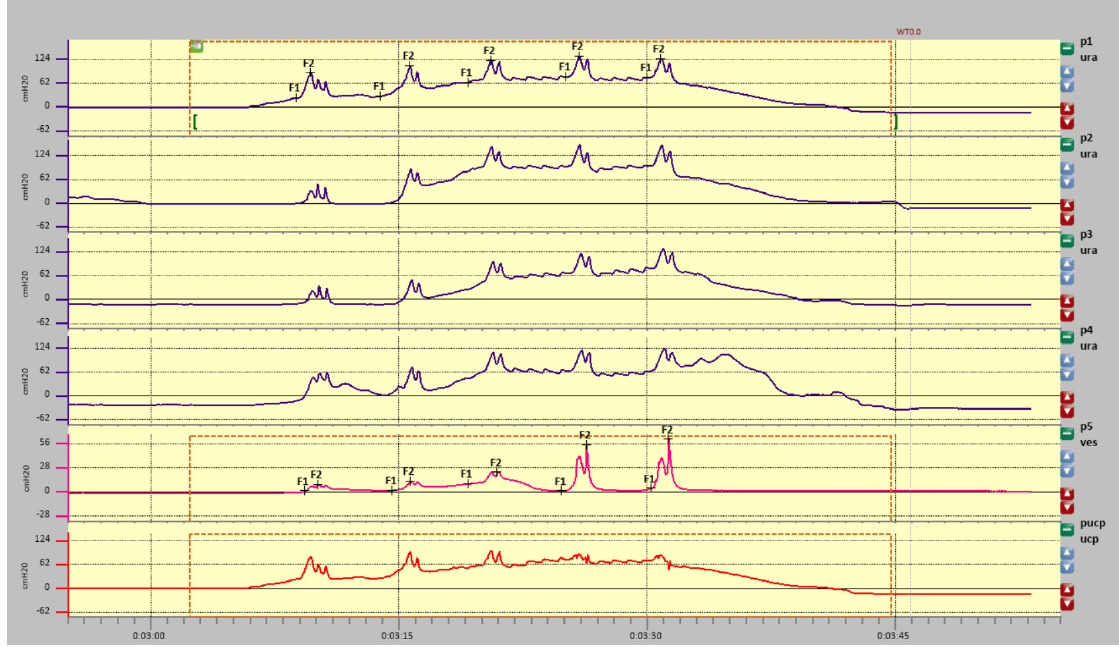
Figure 5. Stress profilometry.